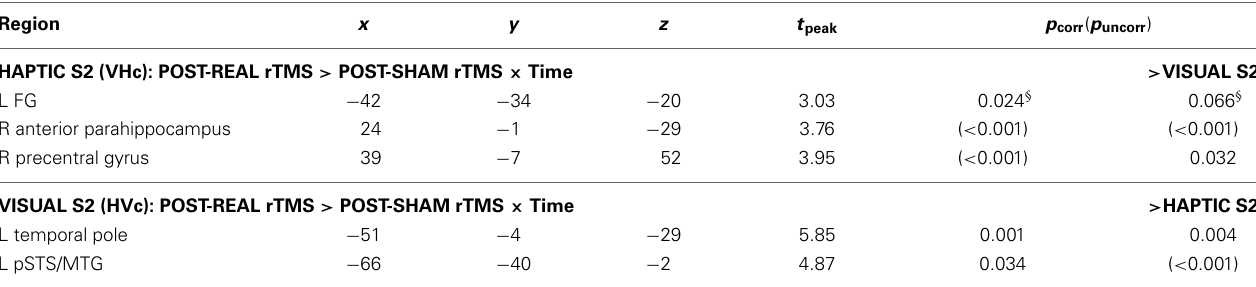
VISUAL S2 (HVc): POST-REAL rTMS > POST-SHAM rTMS × Time > HAPTIC S2 L temporal pole − 51 − 4 − 29 L pSTS/MTG − 66 − 40 − 2 ( <